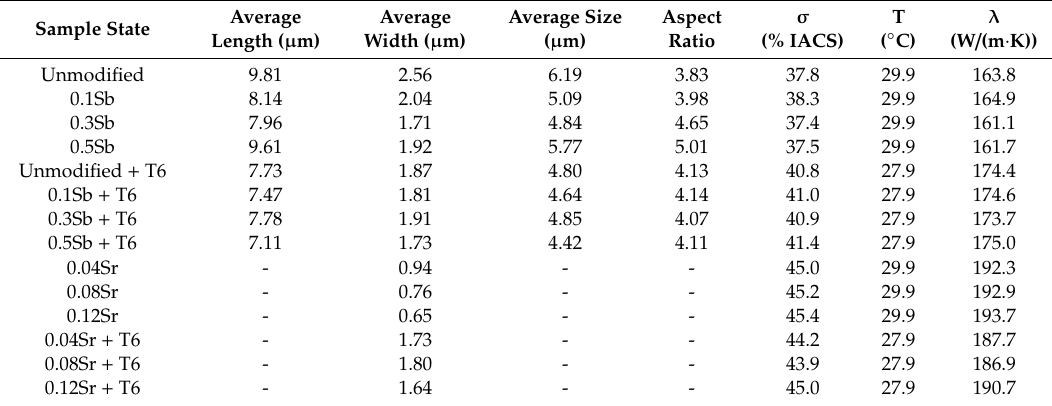
Table 2. The eutectic silicon characteristics, measured electrical ( σ ) conductivity, temperature (T) and calculated thermal ( λ ) conductivity values of the